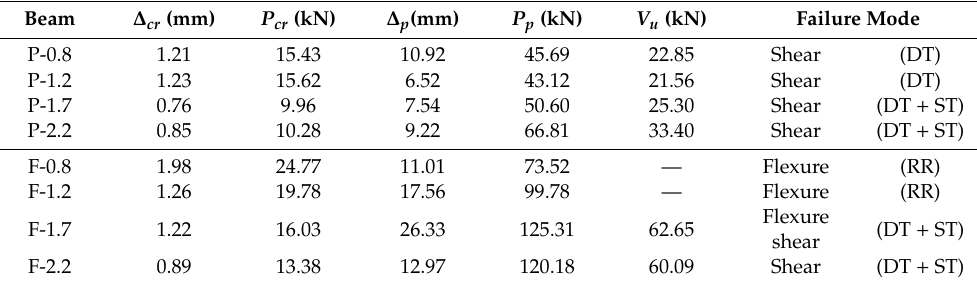
Table 4. The main deflection and load